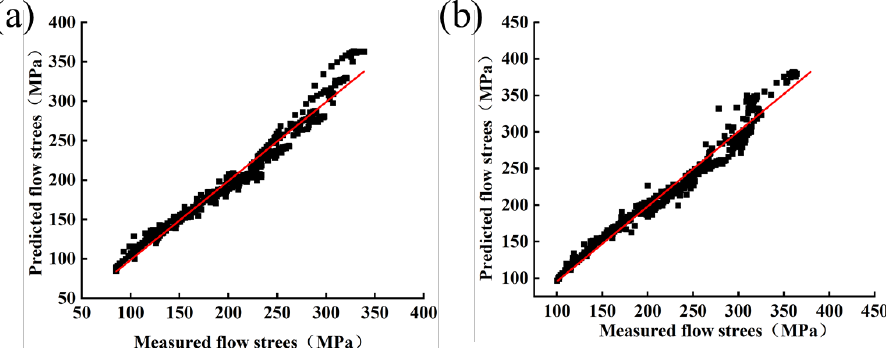
Figure 13. Correlation between predicted and experimental values of flow stress: ( a ) Mo − 1.5wt% Al 2 O 3 , ( b ) Mo − 1.5wt% ZrO 2 .